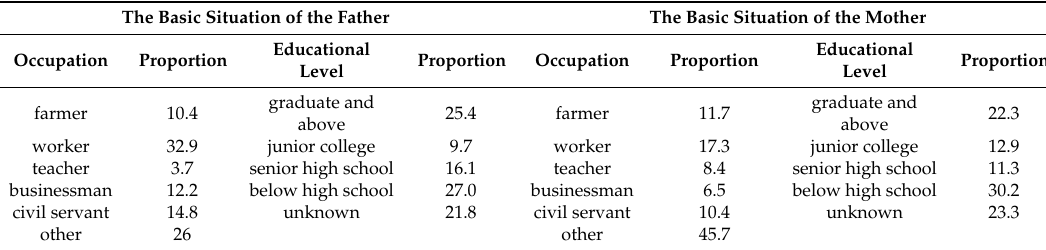
Table 7. The basic situation of